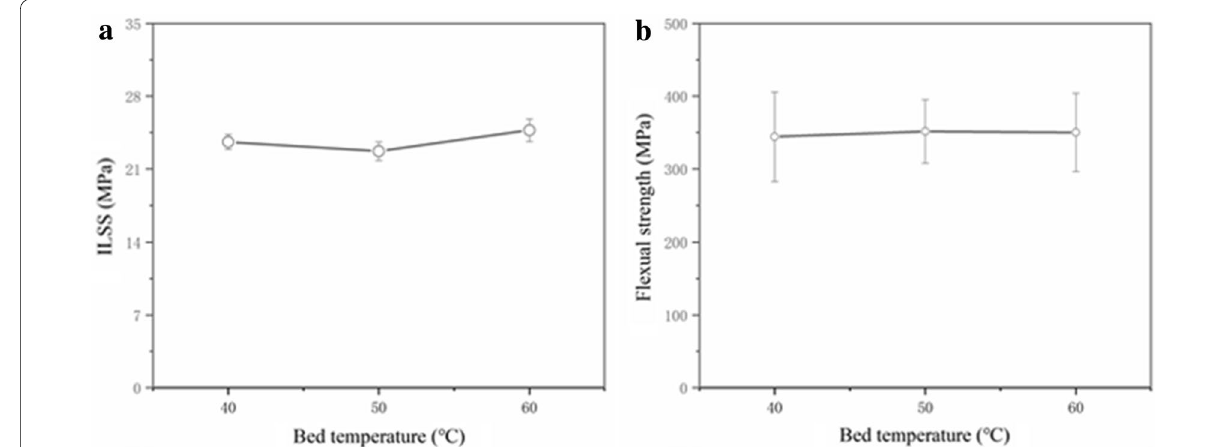
Figure 8 ILSS and flexural strength at different basement temperatures